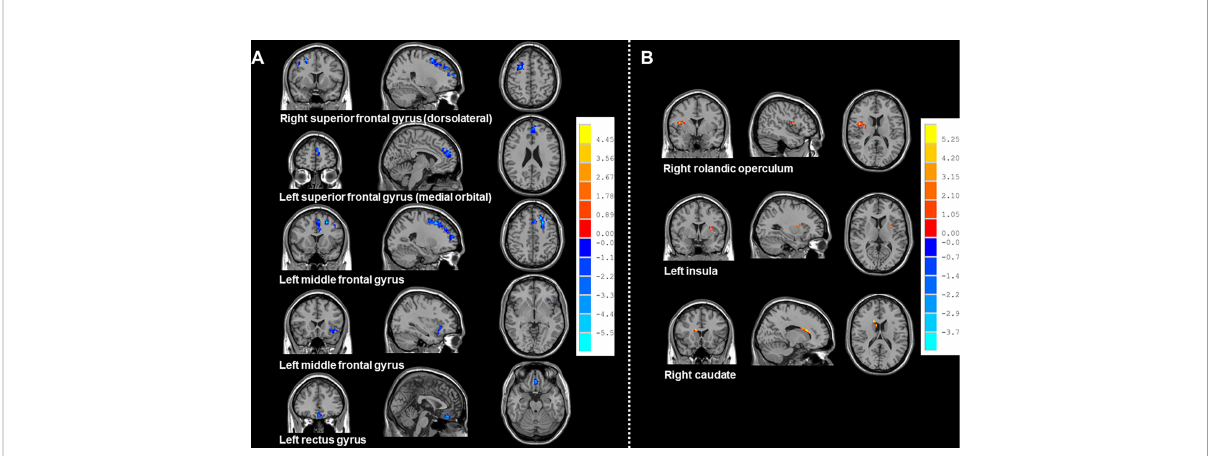
FIGURE 3 Brain regions showed altered ReHo values between NSCLC patients received pemetrexed plus carboplatin chemotherapy, paclitaxel plus carboplatin chemotherapy and HCs. NSCLC: non-small cell lung cancer; HCs: healthy controls. ReHo: regional homogeneity. (A) Brain regions with altered Reho values between NSCLC patients received pemetrexed plus carboplatin chemotherapy and HCs. The results were obtained by two-sample t -tests. The signi fi cance threshold was set at P <0.001 at the voxel-level and P <0.05 at the cluster-level and were corrected for multiple comparisons using Gaussian Random Field (GRF) theory with a minimum cluster size of 38 voxels (two tailed). (B) Brain regions with altered Reho values between NSCLC patients received paclitaxel plus carboplatin chemotherapy and HCs. The results were obtained by two- sample t -tests. The signi fi cance threshold was set at P <0.001 at the voxel-level and P <0.05 at the cluster-level and were corrected for multiple comparisons using Gaussian Random Field (GRF) theory with a minimum cluster size of 26 voxels (two